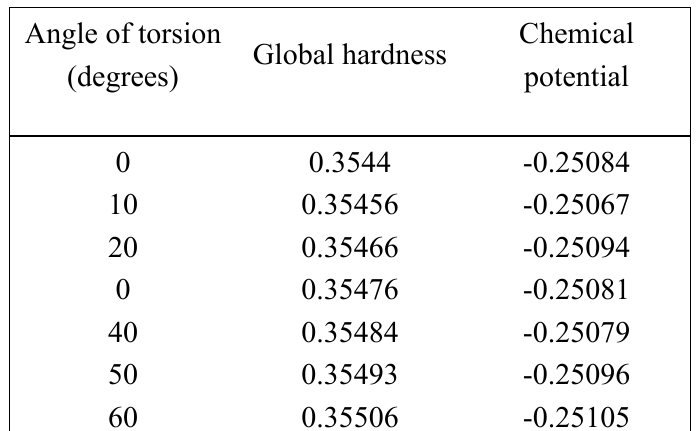
Table 6. The Global hardness ( η ) and chemical potential ( µ )as a function of torsional angles (all in